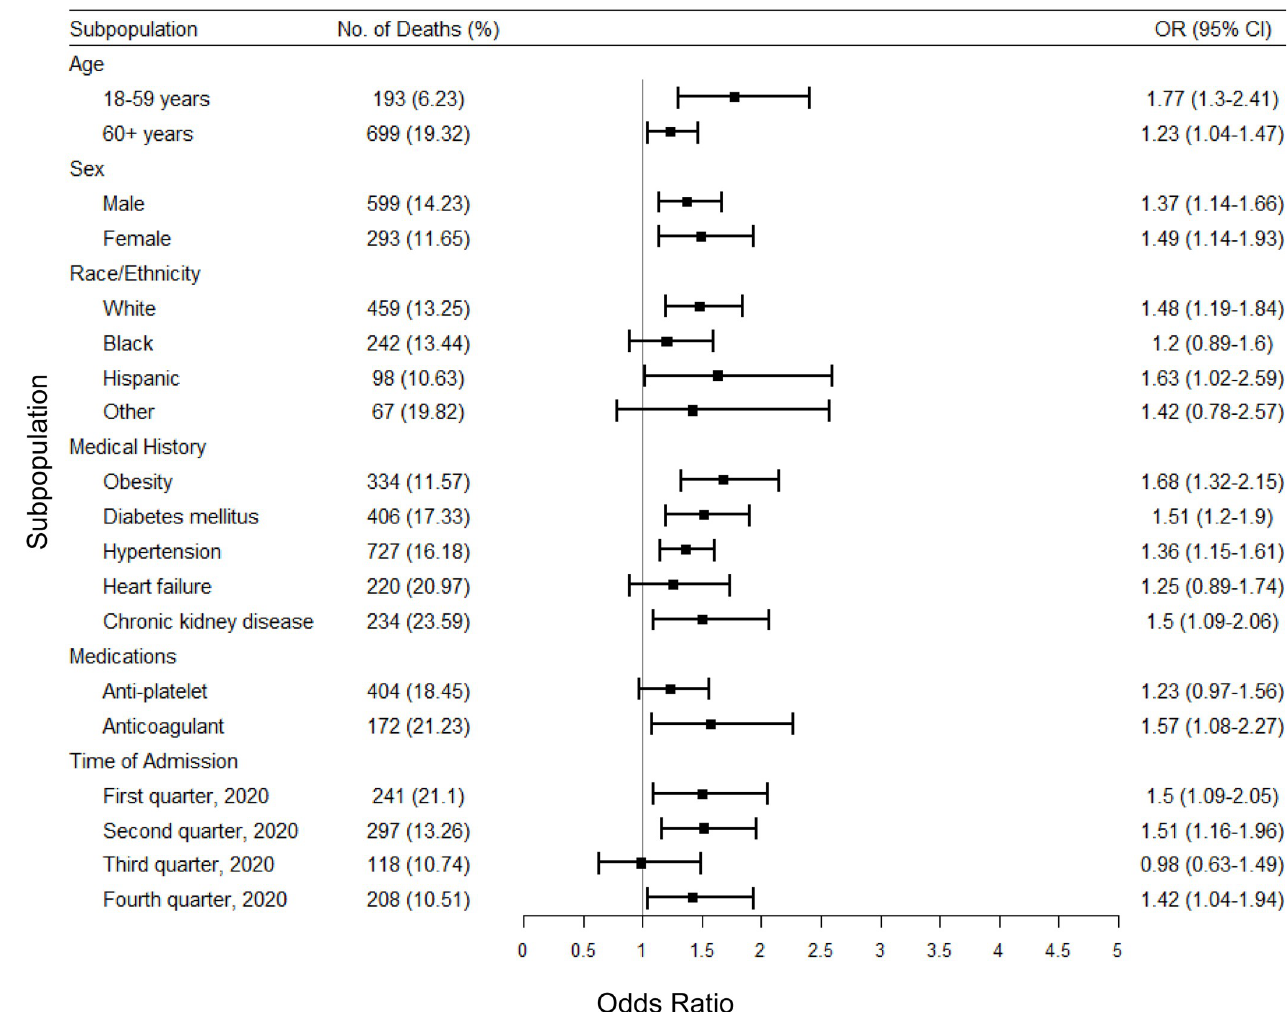
Fig 1. Multivariate analysis of associations between smoking and death in subpopulations among the propensity-matched study population of the AHA COVID-19 CVD Registry from December 2020 to March 2021. Death is defined as patient’s disposition status “Expired” at the time of discharge. Obesity is defined as BMI > = 30 kg/m 2 . OR, Odds ratio; CI, Confidence